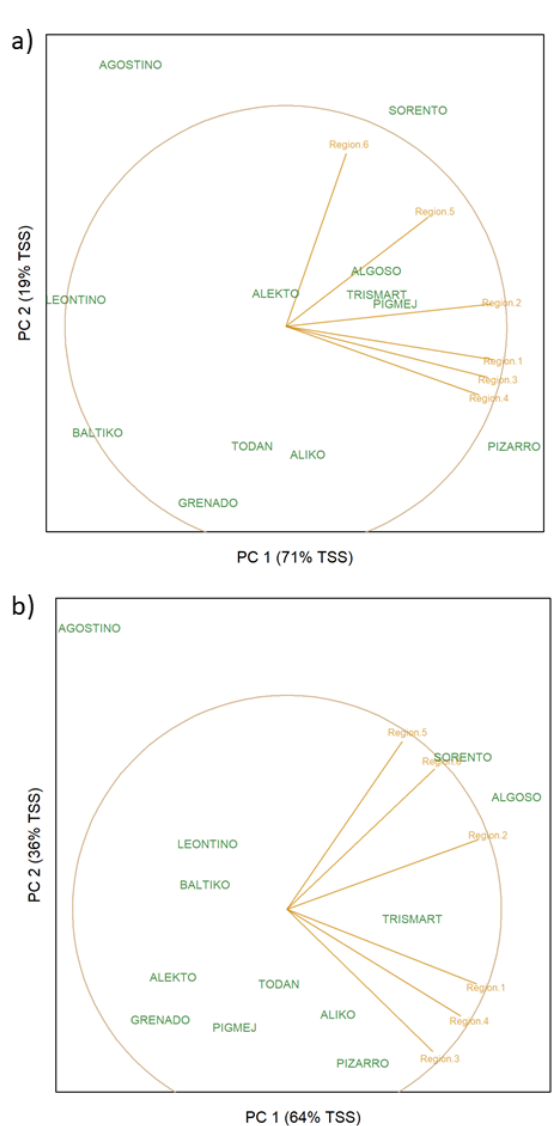
Figure 5. GGE biplots based on adjusted means of cultivar × region combination for the moderate-input crop management MIM ( a ), and for the high-input crop management HIM ( b ). PC, principal component; TSS, total sum of squares.